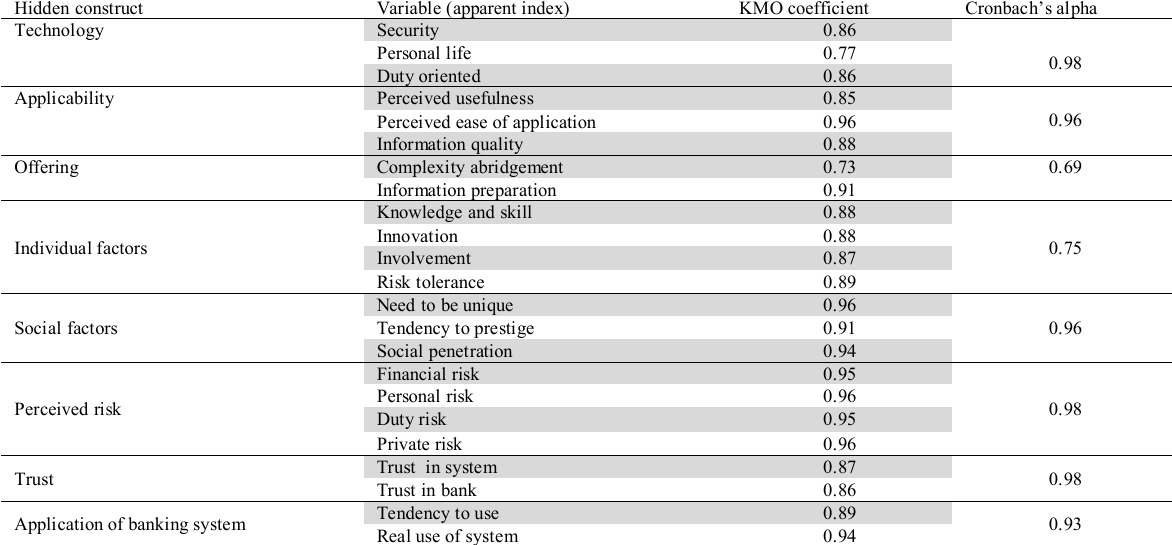
The summary of KMO and Cronbach alpha